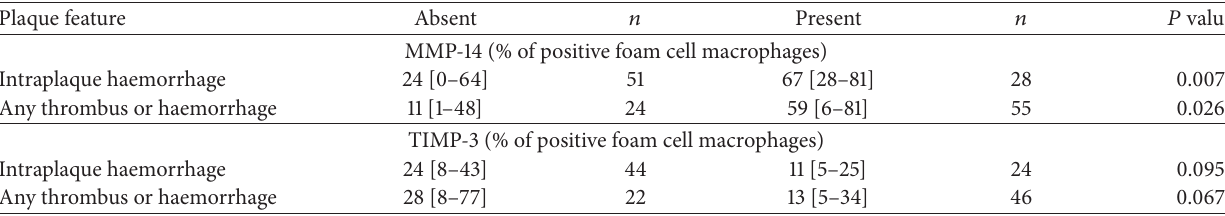
Table 6: MMP-14 and TIMP-3 expression and plaque